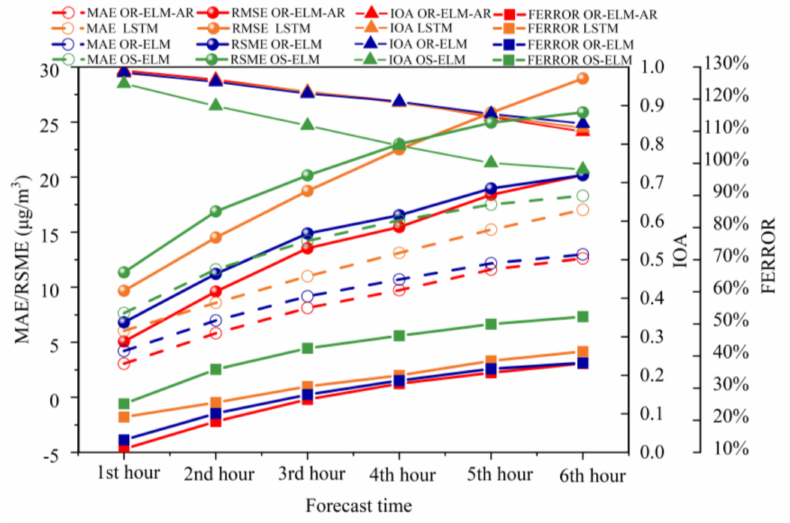
Figure 10. Comparison of forecast performance for four